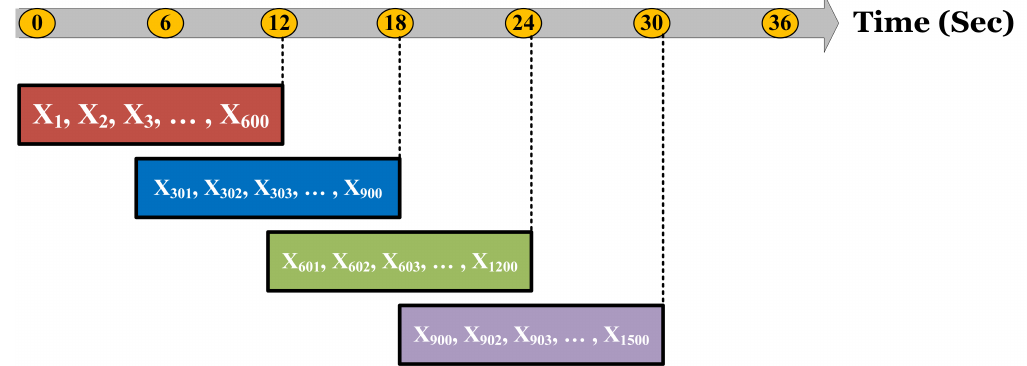
Figure 4. A visual representation of a 12 s sliding window data plus 50% overlapping from a previous